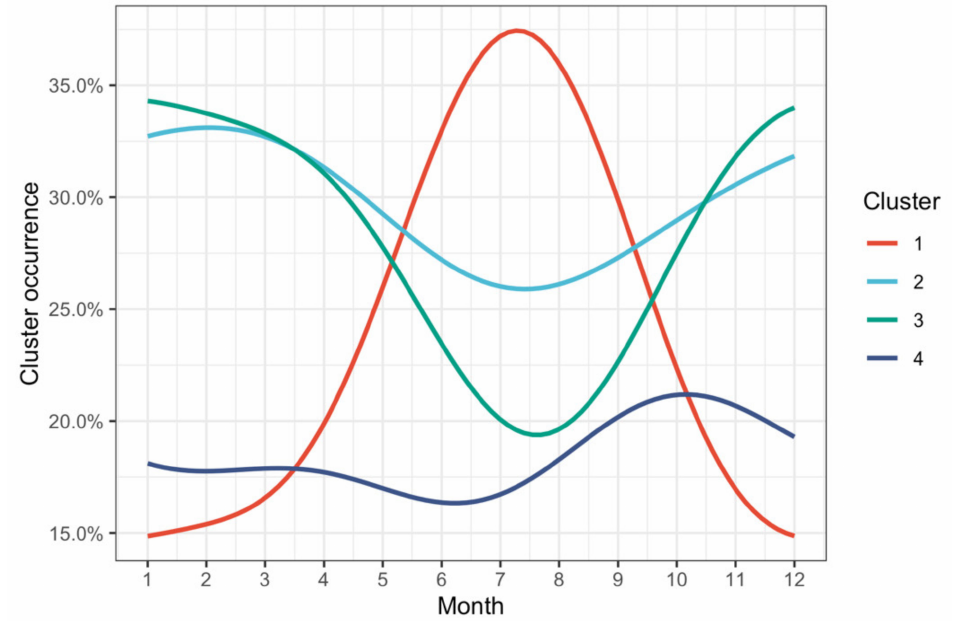
Figure 7. Seasonal variability of clusters’ monthly occurrence.